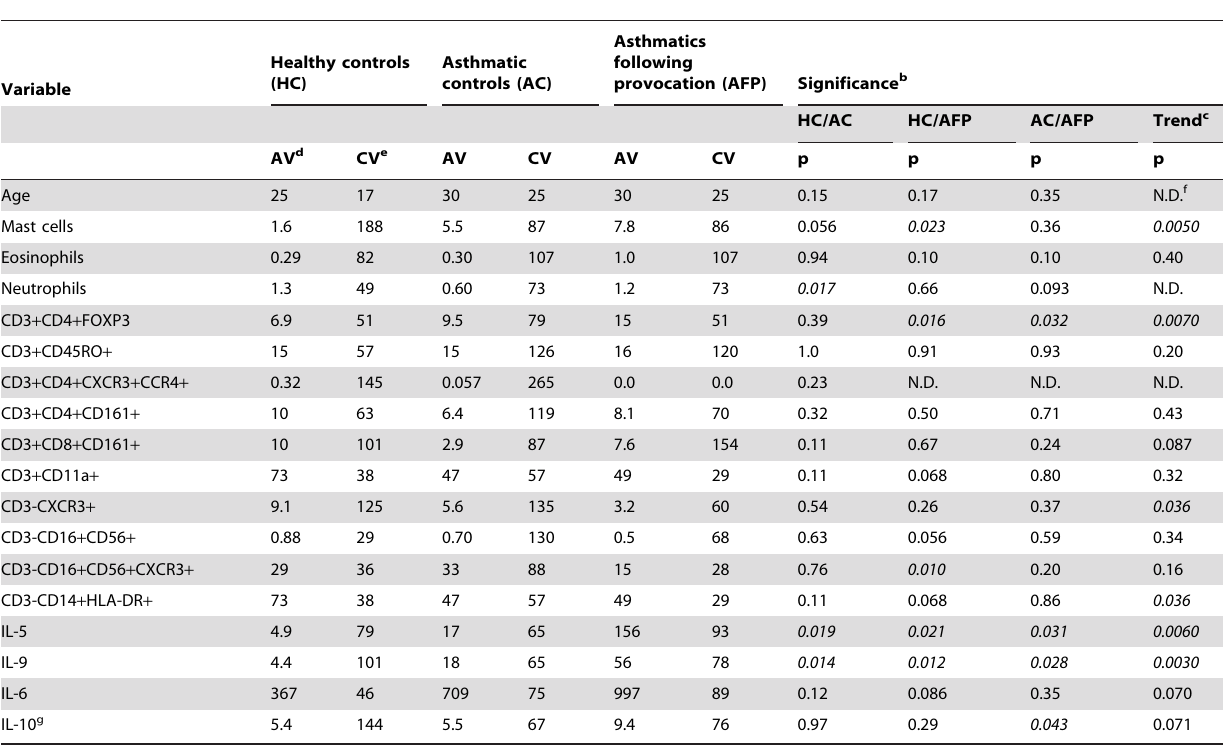
Table 3. Cytokine and BAL cell levels in BALF from 1) Healthy controls 2) Asthmatic controls and 3) Asthmatics following provocation.